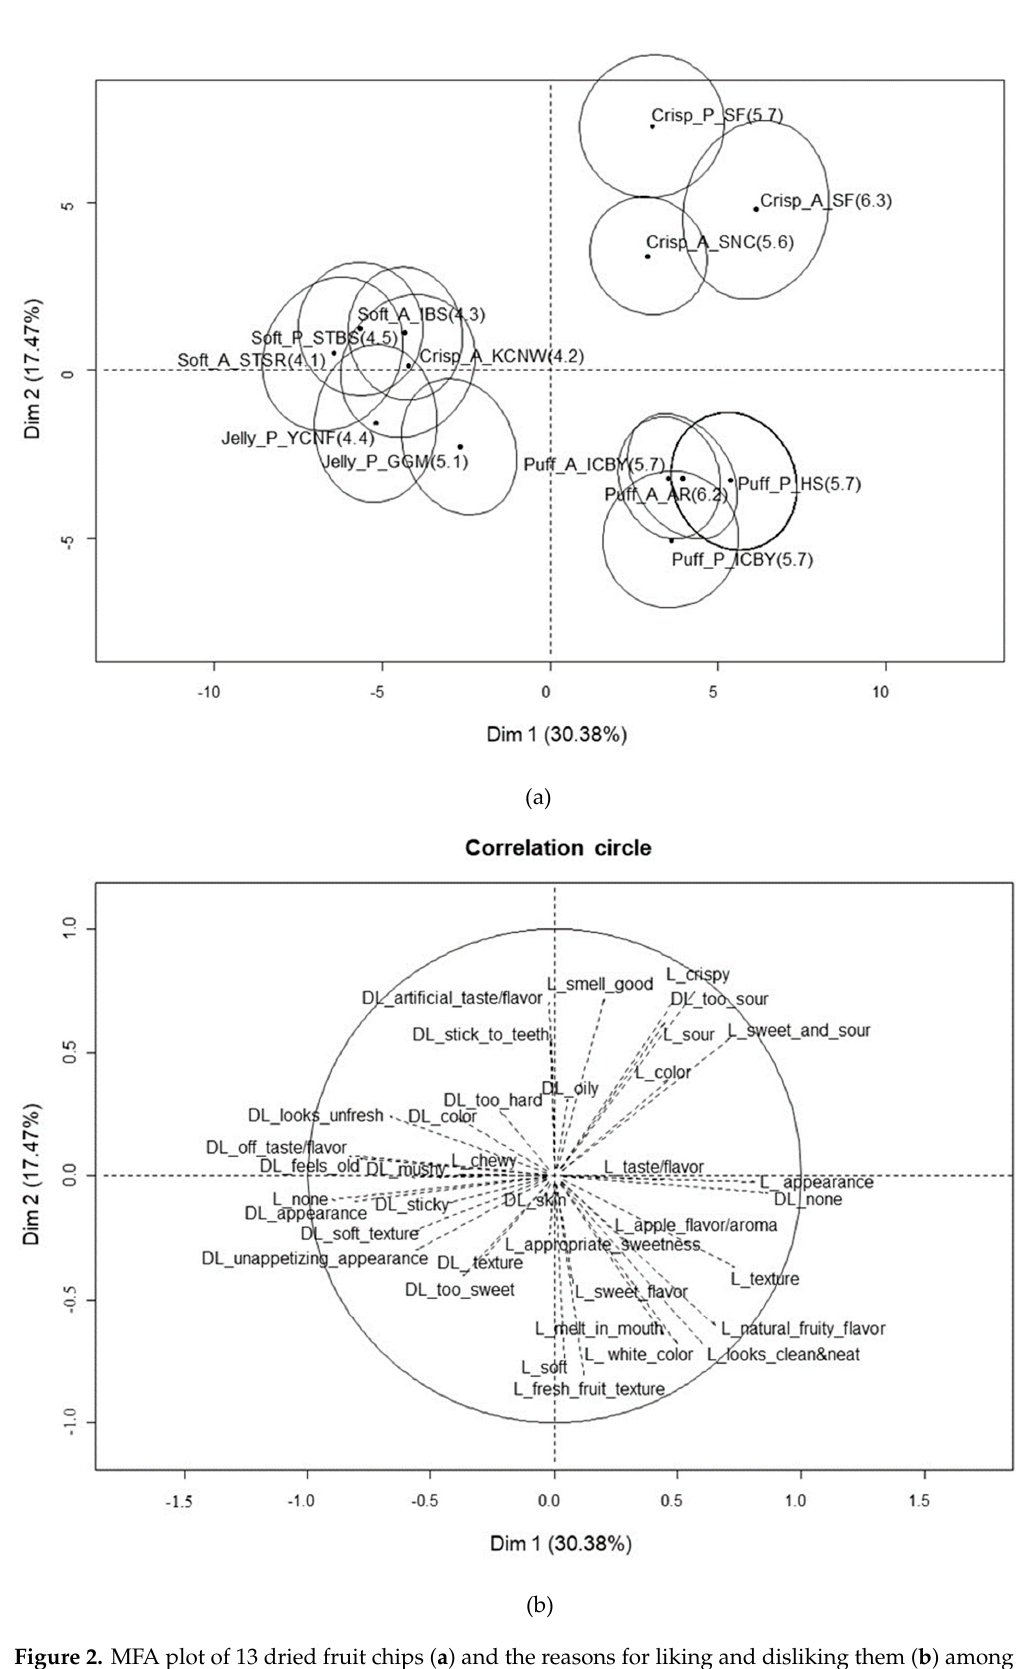
Figure 2. MFA plot of 13 dried fruit chips ( a ) and the reasons for liking and disliking them ( b ) among Chinese consumers. Chinese